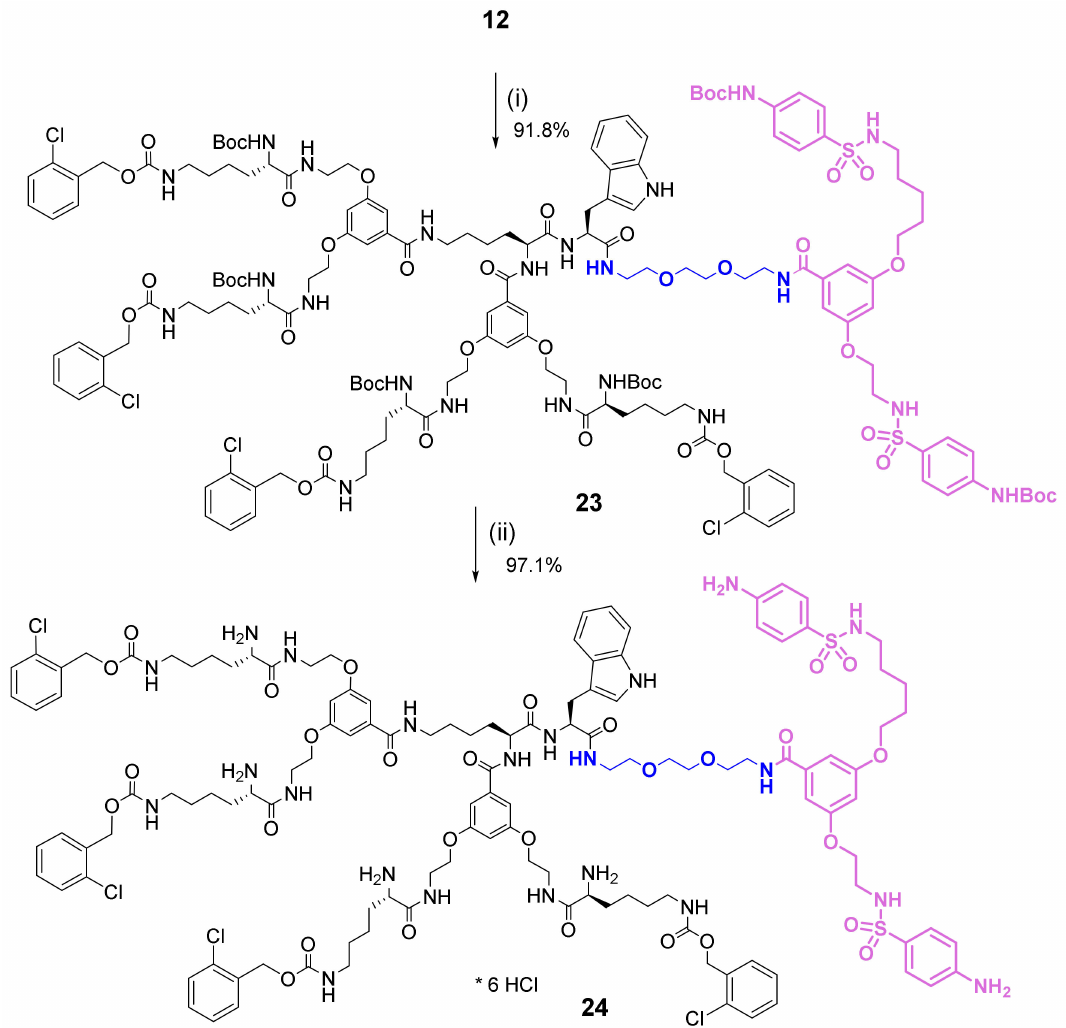
Scheme 4. Synthesis of bola dendrimer 24 from intermediate 12 with left side Dendron terminated with 2-chloro- benzyloxycarbonyl (2-Cl-Z) residues and right side dendron functionalized with p -aminosulfonic acid (PAS). Conditions: ( i ) Boc-Lys(2-Cl-Z)-OH, DCC/HOBt, Et 3 N, DMF, 72 h ( ii ) sat.